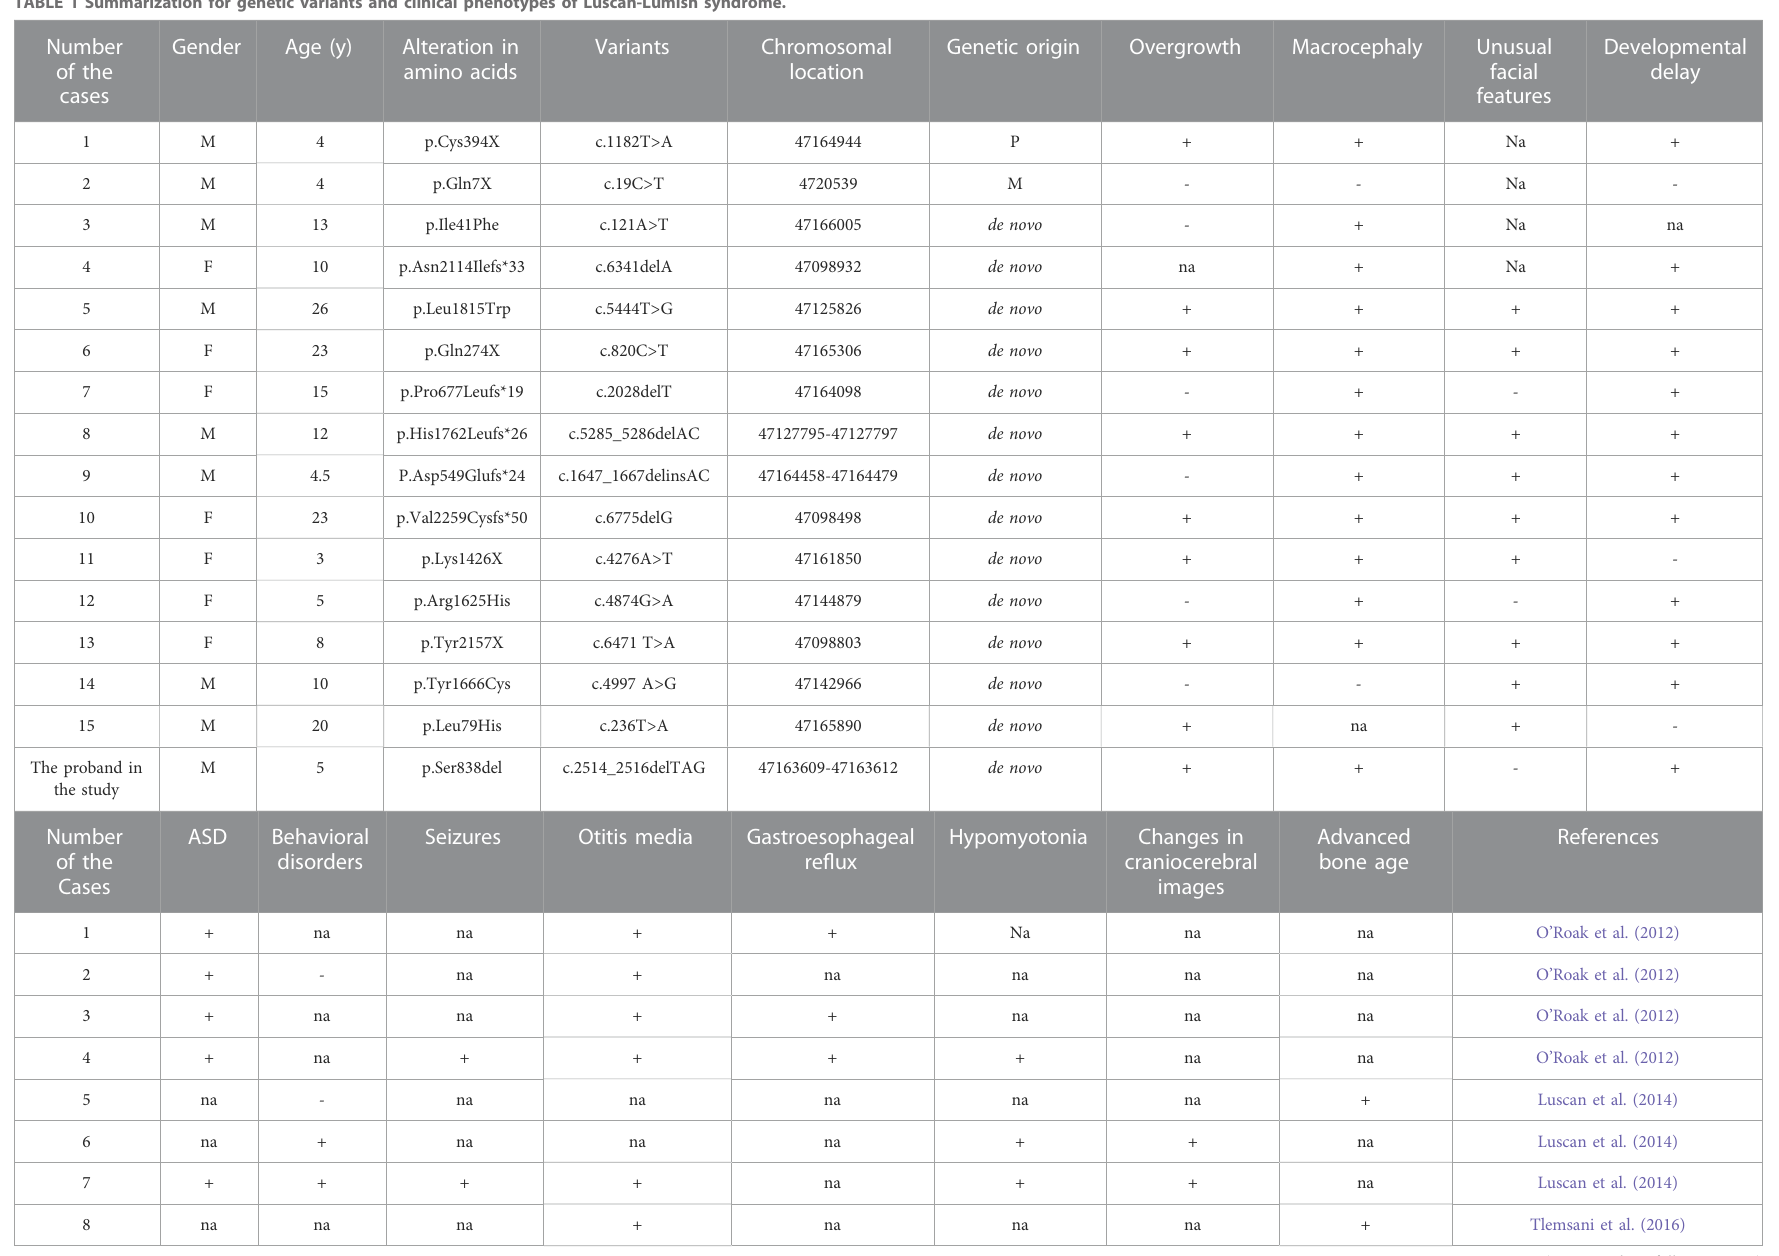
Chromosomal Genetic origin Overgrowth Macrocephaly Unusual location